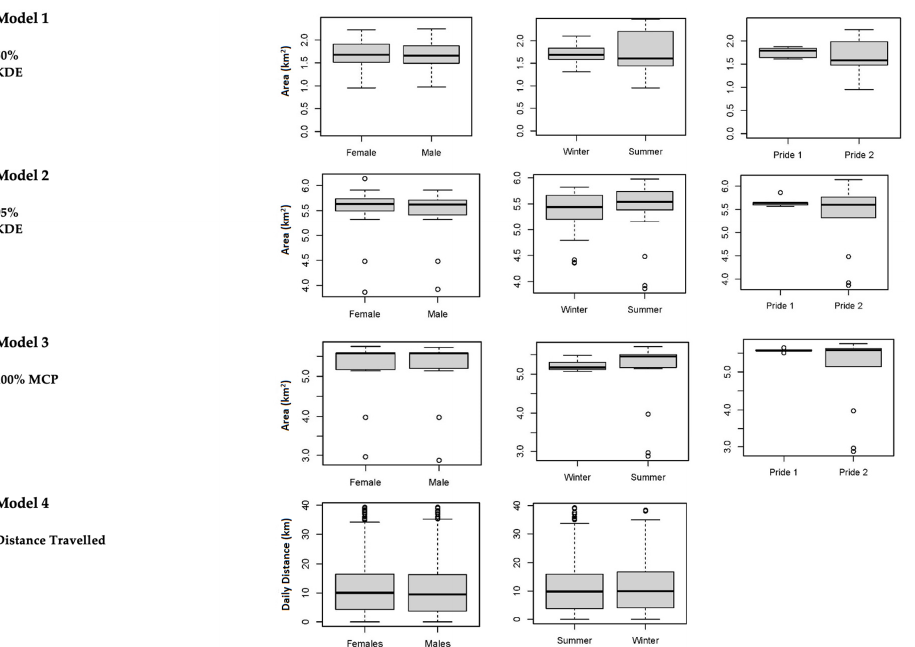
Figure 5. Home range distribution for male and female lions for the Royal and Tsau prides, using KDE (100%, 95% and 50%) ( a – d ), Tula Tsau Conservation Area, Limpopo, South Africa.